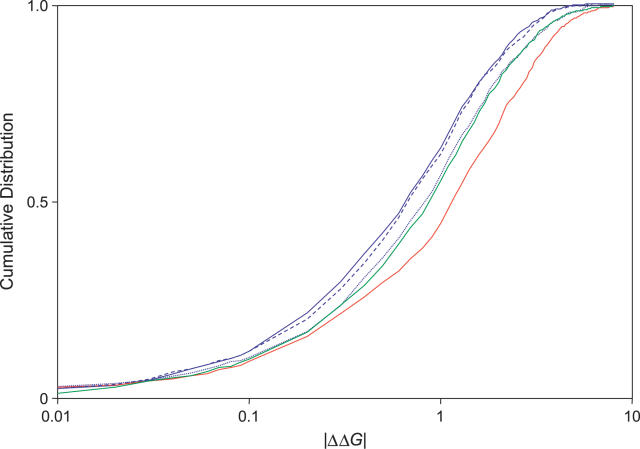
Cumulative Distribution of Absolute Errors in Reconstruction Stabilities (|ΔΔG|)Colour code as in Figure 2. Error with BI reconstructions are shown when averaging is performed over 100 sequence reconstructions (solid line), ten sequence reconstructions (dashed line), and a single reconstruction (dotted line).